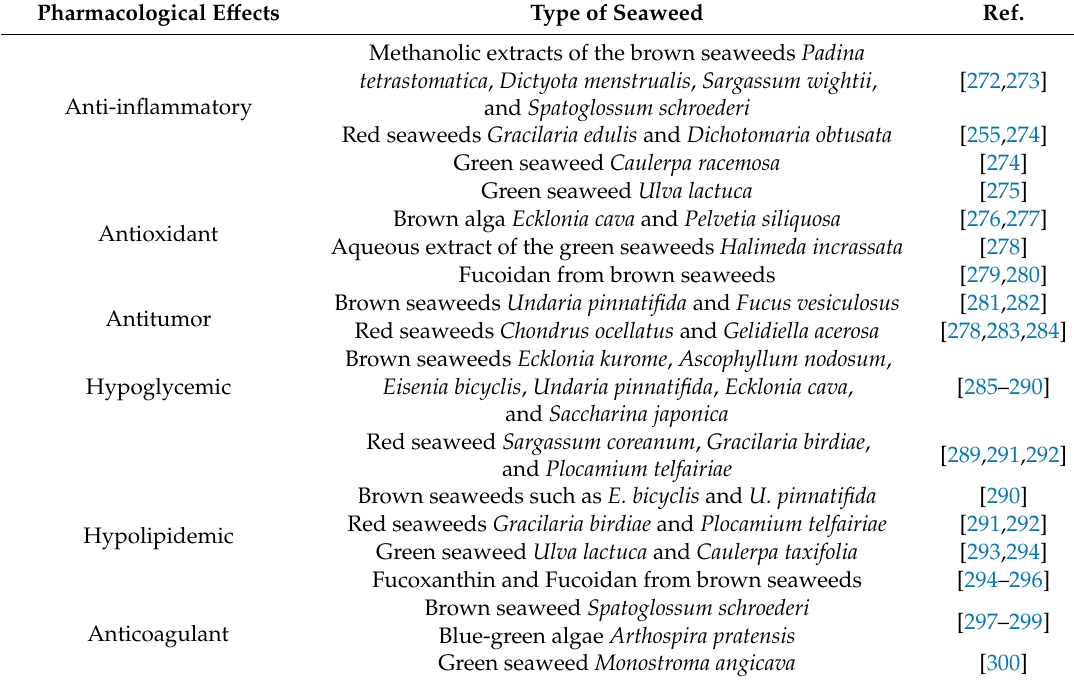
Table 3. In vivo pharmacological e ff ects for bioactive compounds found in